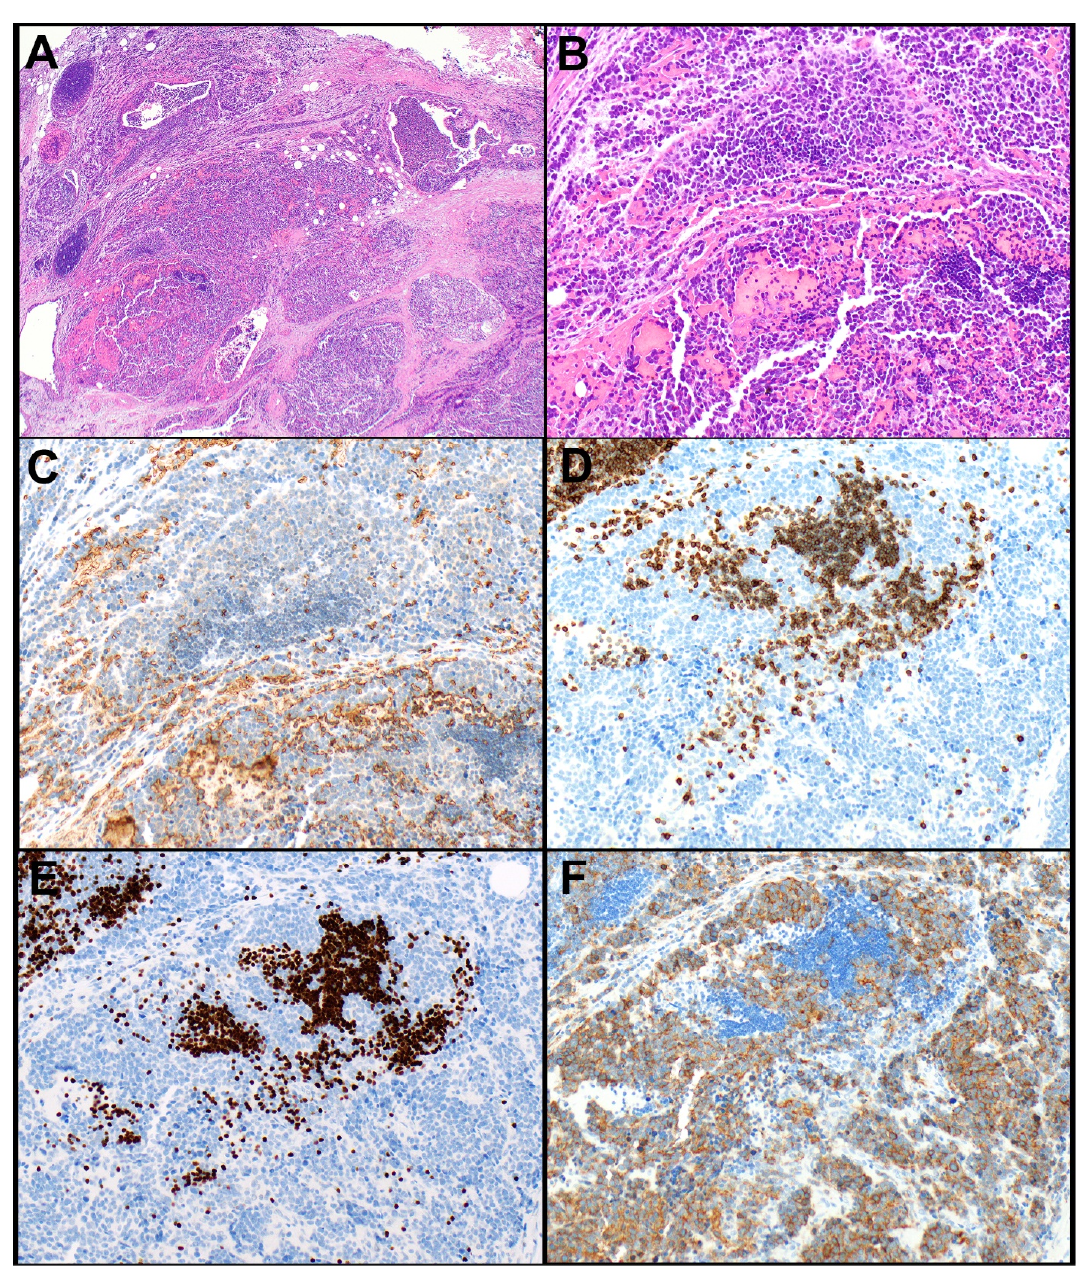
Figure 4. Thymic small cell carcinoma. ( A ) This tumor grows in nests and small sheets of tumor cells. ( B ) The tumor cells are medium-sized, have a high nuclear-to-cytoplasmic ratio and dark, finely dispersed nuclear chromatin. ( C ) The tumor cells are negative for GLUT1 (note staining in erythrocytes). ( D ) The tumor cells are also negative for CD5 (note clusters of CD5-positive T lym- phocytes/thymocytes). ( E ) TdT highlights clusters of thymocytes in between nests of tumor cells. ( F ) CD117 is expressed in 100% of tumor cells. Magnification, H&E ×40 ( A ), ×200 ( B ), GLUT1 ×200 ( C ), CD5 ×200 ( D ), TdT ×200 ( E ), CD117 ×200 ( F ).